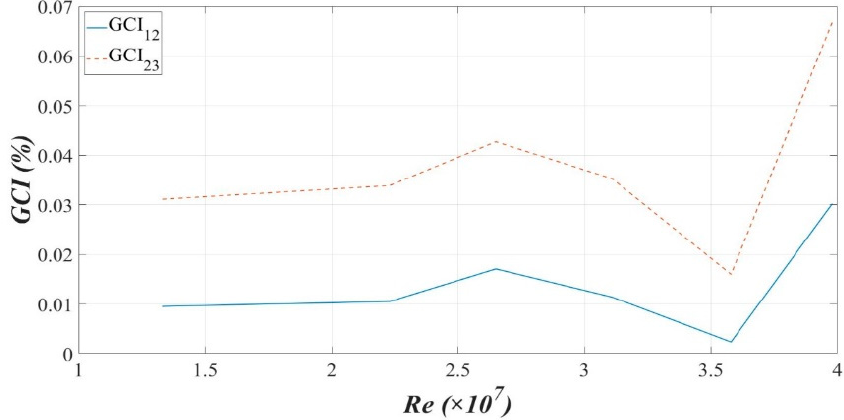
Figure 5. Grid independence analysis of the resistances on the basis of the SUBOFF model by evaluating different grid convergence index (GCI) values.